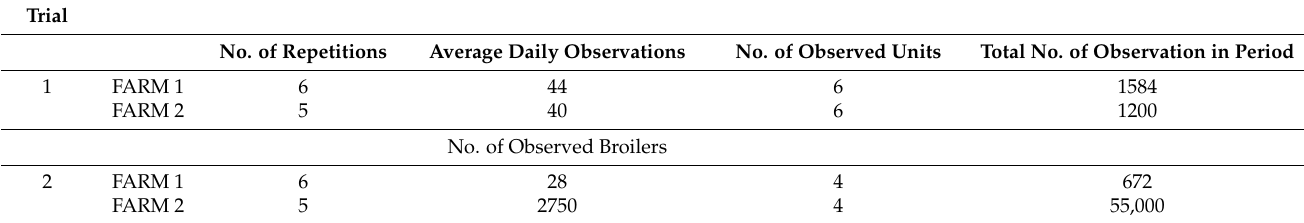
Table 3. Course and experimental setup of the investigation (between November 2019–October 2021).